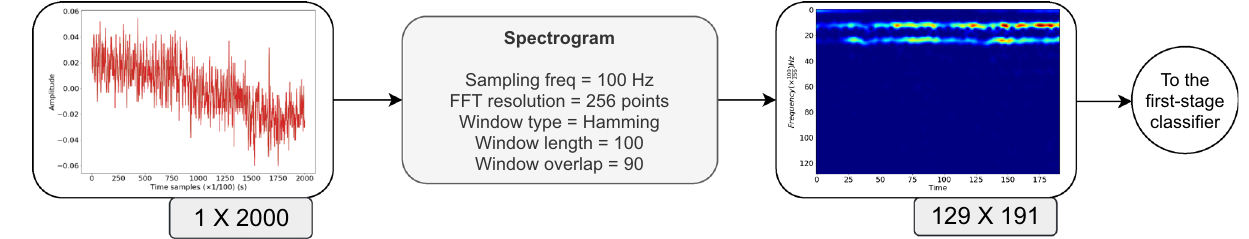
Figure 2. The preprocessing step to convert time-series tremor recordings into 2D spectrotemporal representations of the signals to be processed with the first-stage classifier of NeurDNet